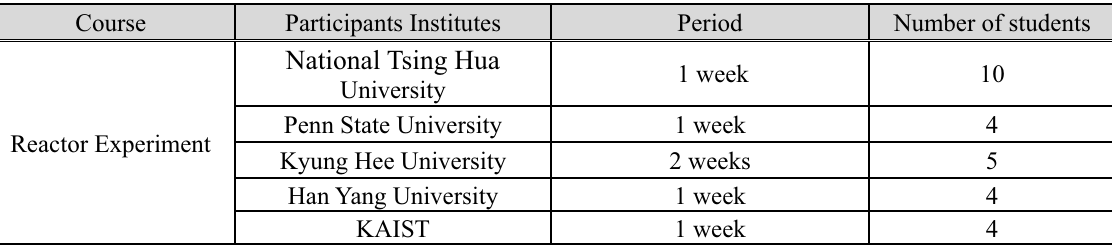
Table II. Reactor Physics Experimental Proposed Experimental